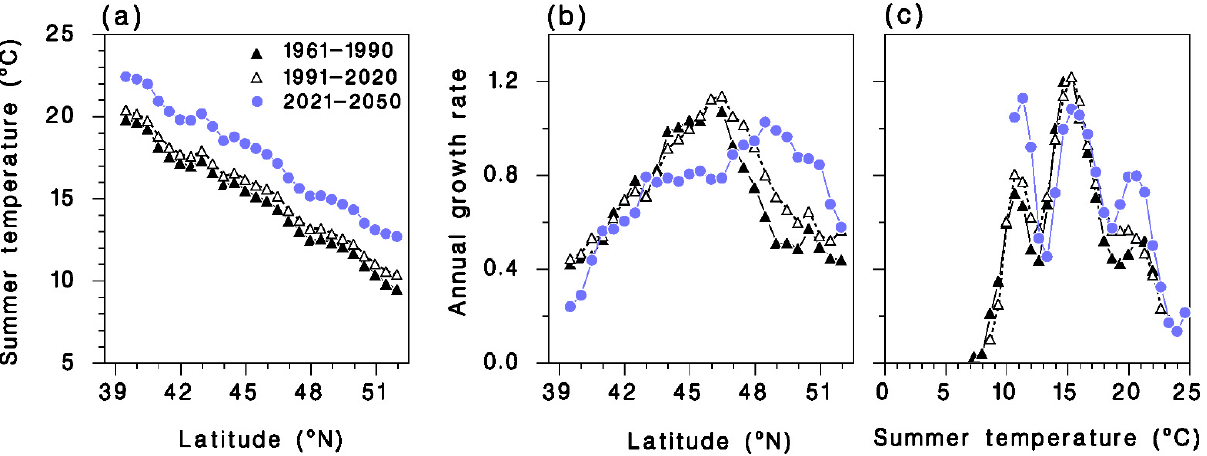
Figure 8. Relationship between latitude and ( a ) mean summer temperature from May to September and ( b ) average annual population growth rate of Actia interrupta compiled from 20,000 random locations in eastern North America. ( c ) Relationship between annual population growth rate and mean summer temperature. Model output from daily air temperature records 1961–1990 ( ▲ ), 1991–2020 ( Δ ), or from climate-changed disaggregated normals 2021–2050 ( ● ).